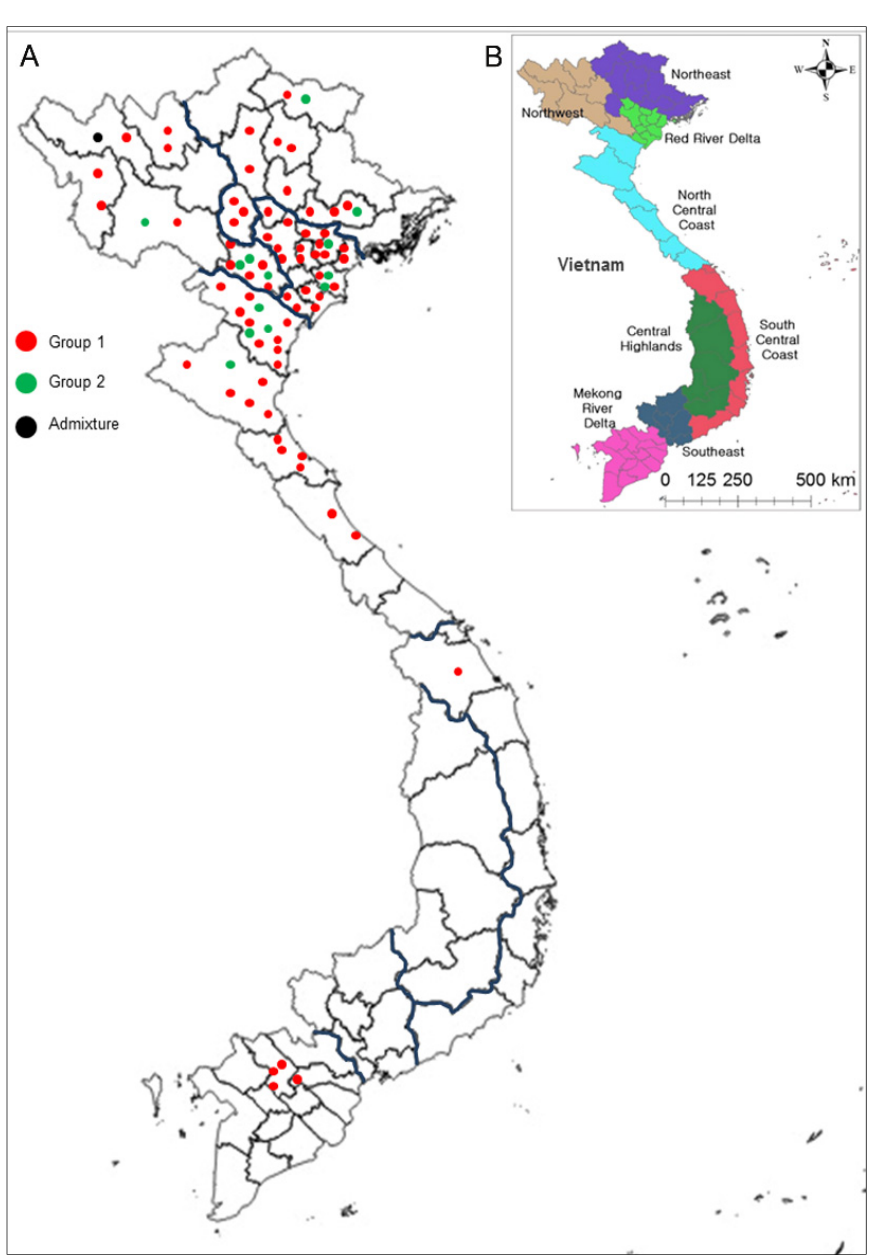
Figure 1. Geographic distribution of Vietnamese rice accessions in this study. ( A ) The 79 rice landraces collected from northern Vietnam belonging to AGI collection and 4 rice accessions collected from Mekong River Delta belonging to check group. ( B ) The eight main regions of Vietnam based on geographic and climatic conditions. Detailed information of the materials is provided in Table